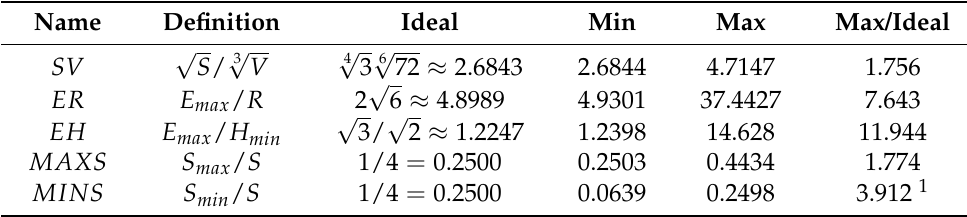
Table 2. Mesh quality of the geosphere 3D model.